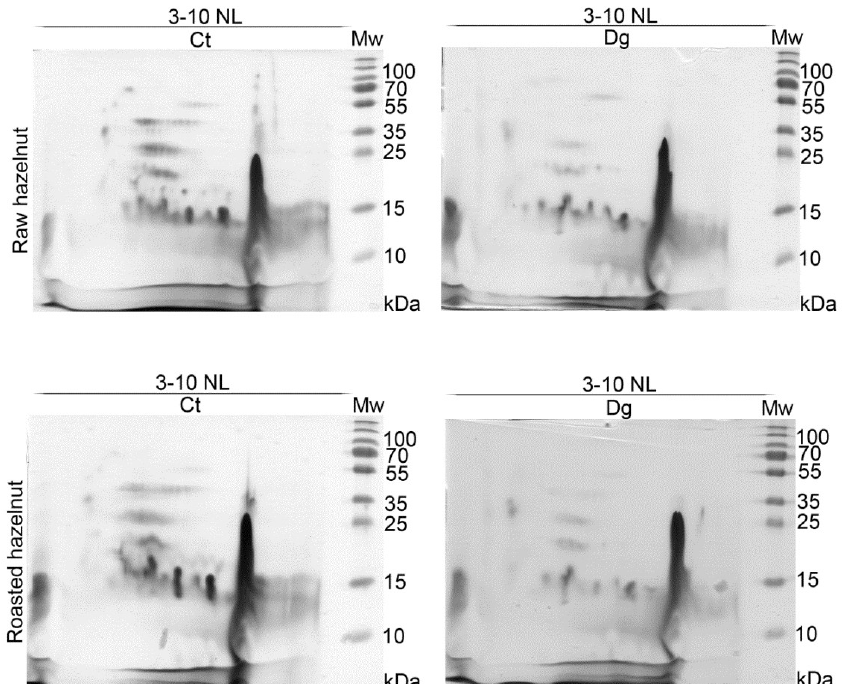
Figure 2. 2D SDS-PAGE (14%) in reducing conditions with normal load range of non-defatted raw and roasted hazelnut digesta and their respective controls; Ct—control sample, Dg—gastric phase; Mw—molecular weight markers; kDa—Kilo Daltons; 3–10 NL—nonlinear pH range 3–10.